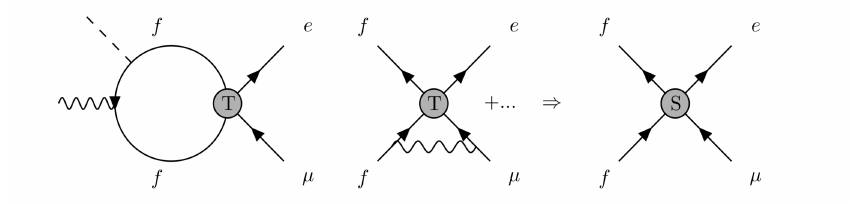
). On the right, one of the diagrams mixing W